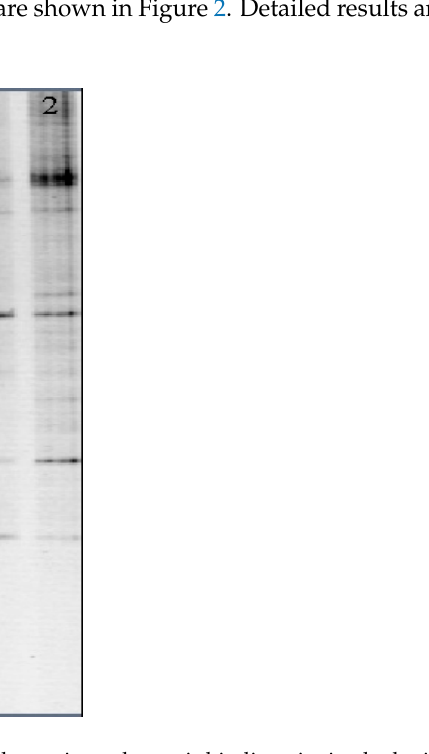
Figure 2. DGGE gel profile of DNA fragments to determine eukaryotic biodiversity in algal microcosms. Lane 1 is for samples collected from station DSTP, and Lane 2 is for samples collected from station Wahiawa State Freshwater Park (WSFP).